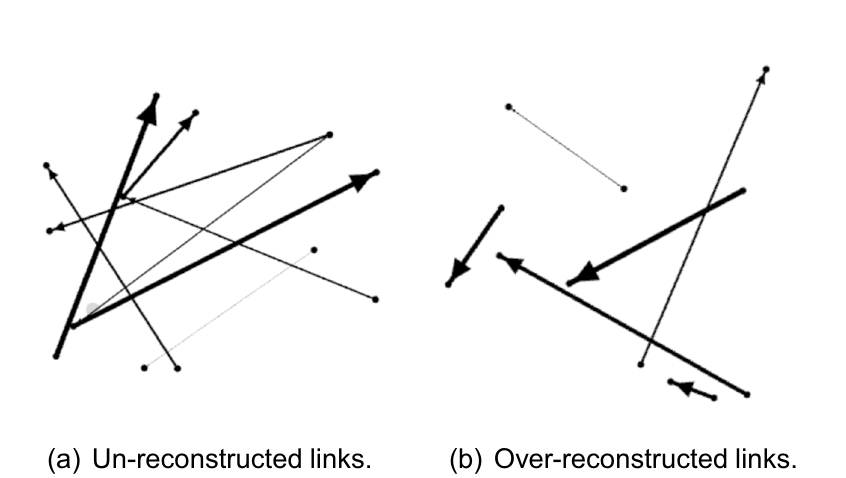
Figure 2. Reconstruction results of debt networks with 50 enterprises. ( a ) Shows the debt relationship before reconstruction, constructed using debt information issued by listed companies. ( b ) Shows the reconstruction result of the debt network by our method based on compressed sensing, whereas ( c ) shows the links that are reconstructed incorrectly, which is the error of reconstruction.